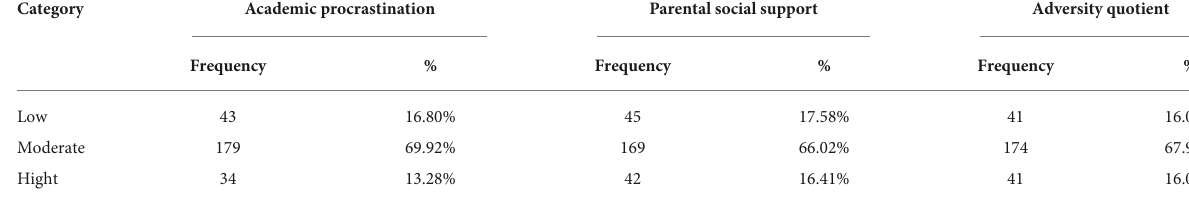
TABLE 2 Frequency distributions of the variables.